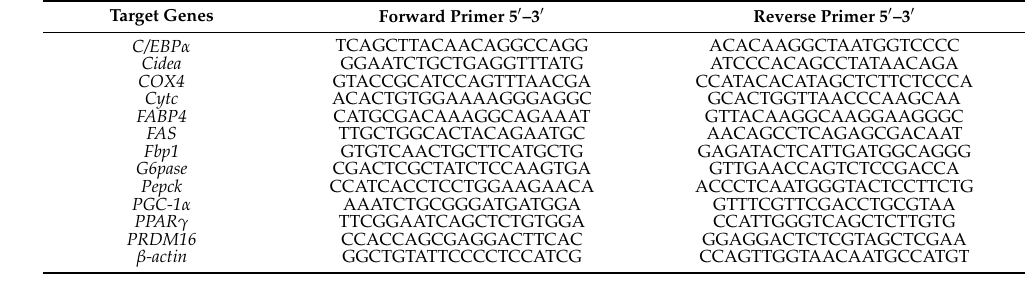
Table 2. Primer sequences used for